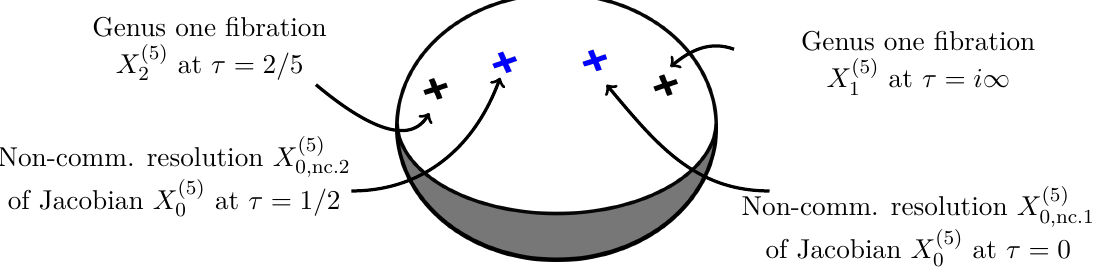
Figure 5 . The stringy Kähler moduli space of generic genus one curves of degree 5 is the modular curve X (5) . For a Calabi-Yau fibration X (5) 1